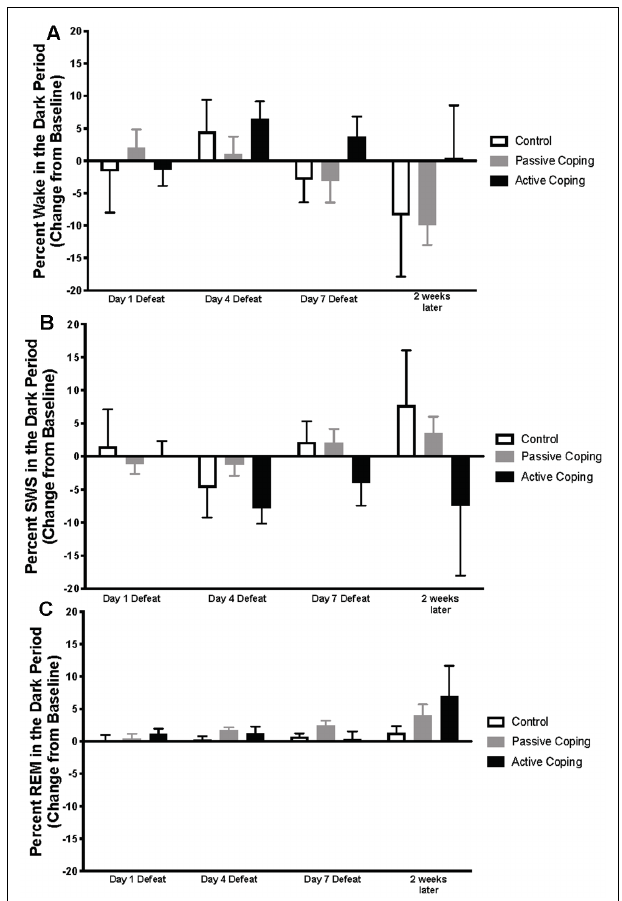
FIGURE 3 | Percent wake, SWS, and REM in the dark period presented as change from baseline on Day 1, 4, and 7 of Defeat, and 2 weeks later. (A) Percent time spent awake during the dark period in control ( n = 7), passively ( n = 15), and actively ( n = 8) coping rats. Groups did not significantly differ in the percent of time they spent in wake at any time point. (B) Percent time spent in slow-wave sleep (SWS) during the dark period in control ( n = 7), passively ( n = 15), and actively ( n = 8) coping rats. Groups did not significantly differ in the percent of time they spent in SWS at any time point. (C) Percent time spent in REM sleep during the dark period in control ( n = 7), passively ( n = 15), and actively ( n = 8) coping rats. Groups did not significantly differ in the percent of time they spent in REM at any time